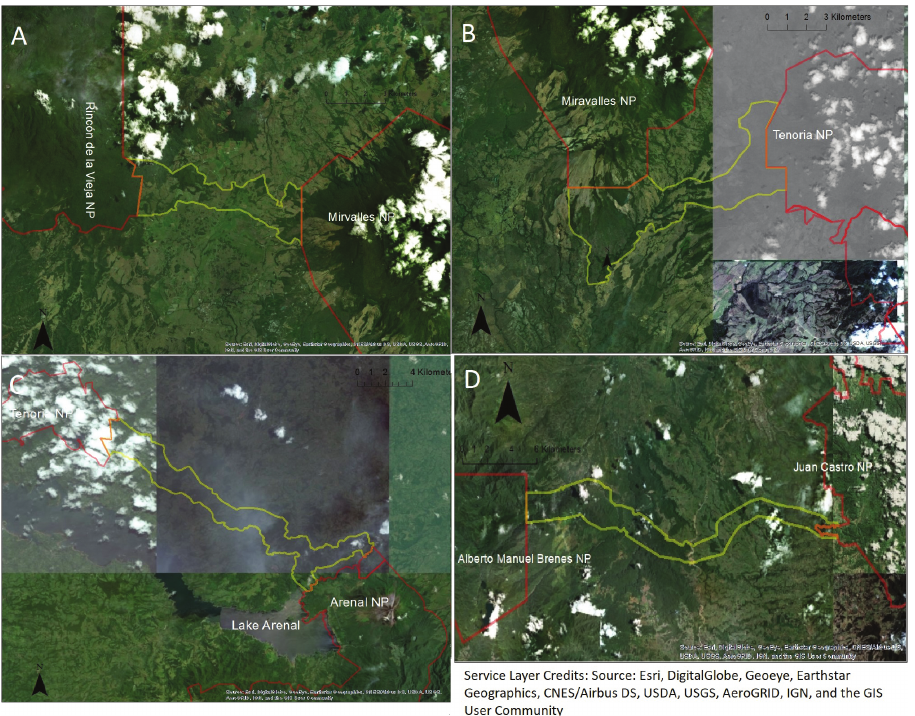
Figure 2. Satellite views of the four proposed biological sub-corridors (in yellow) with adjoining pro- tected areas (in red). Dark green areas indicate the presence of forested